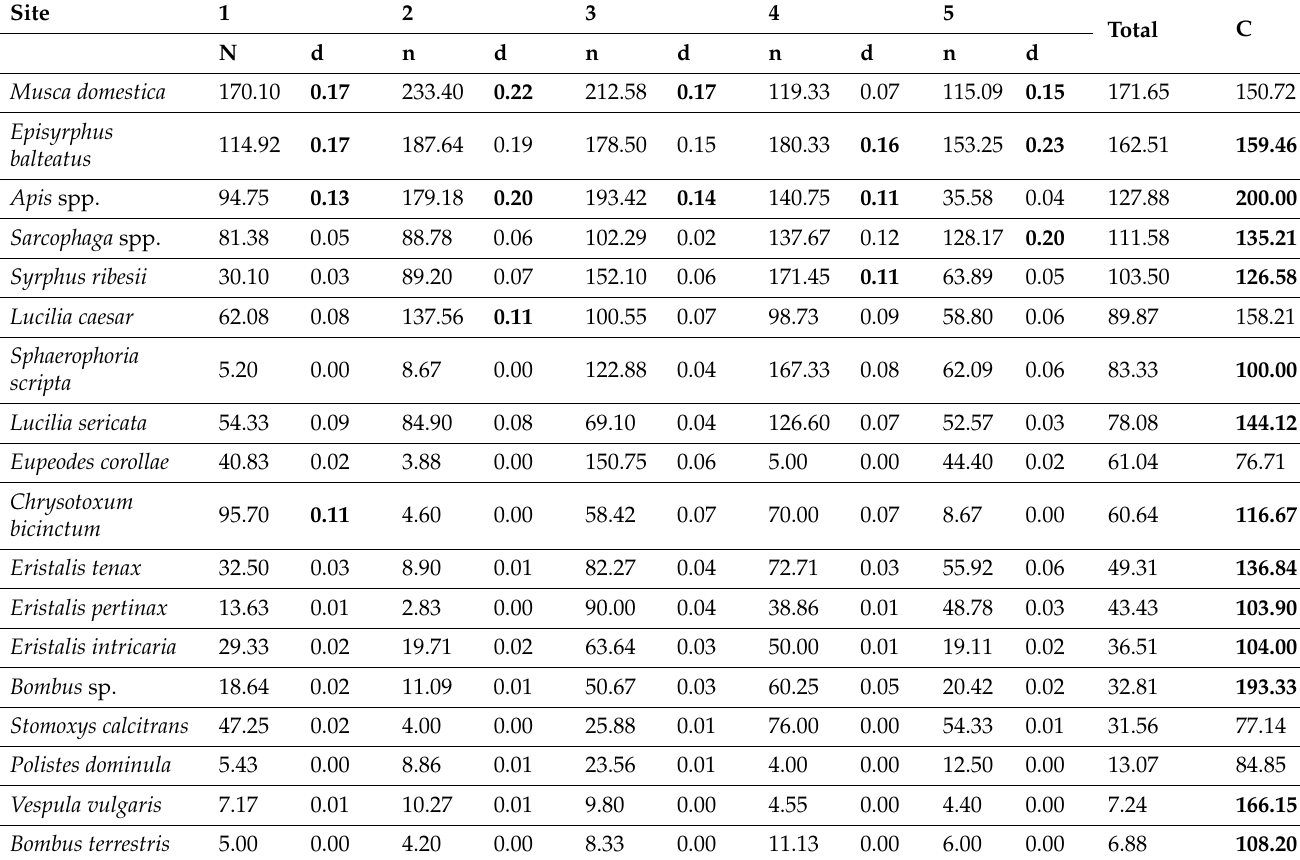
Table 4. The species and community responses of pollinators observed on Fallopia baldschuanica flowers in